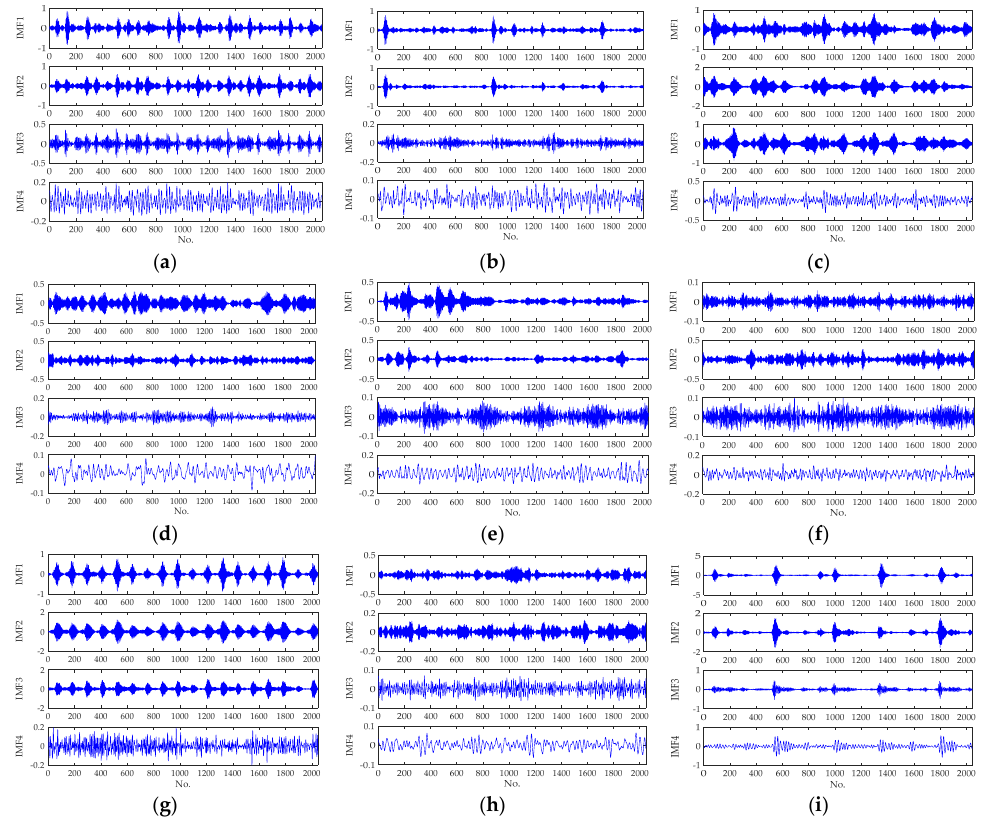
Figure 7. The variational mode decomposition (VMD) decomposition results of signals with different faults: ( a ) inner race (0.007 inches); ( b ) inner race (0.014 inches); ( c ) inner race (0.021 inches); ( d ) ball (0.007 inches); ( e ) ball (0.014 inches); ( f ) ball (0.021 inches); ( g ) outer race (0.007 inches); ( h ) outer race (0.014 inches); ( i ) outer race (0.021 inches).